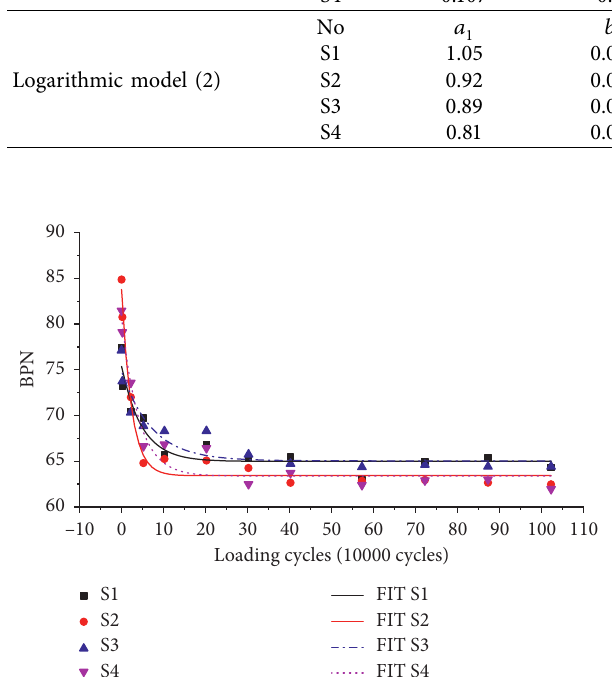
Figure 6: The BPN reduction fitting